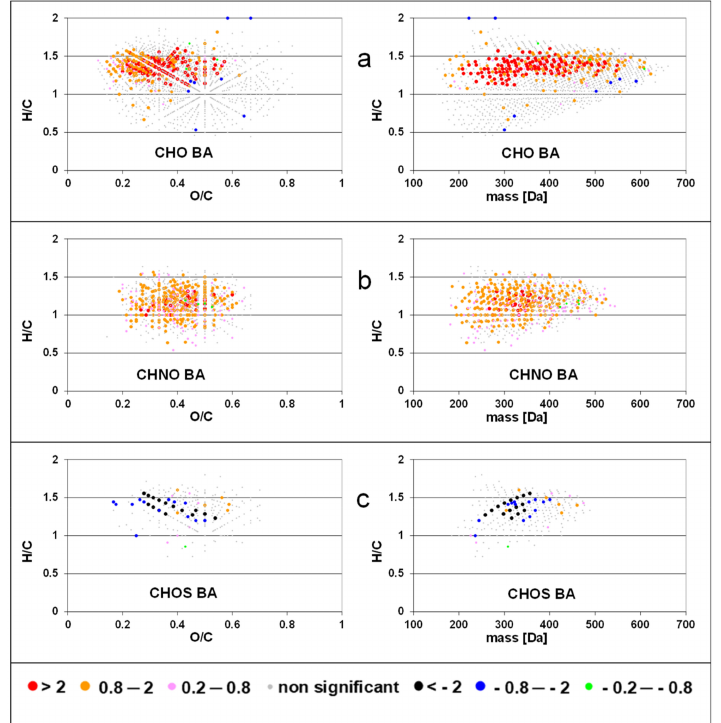
Figure 3. Slopes of regressions between intensities of solid phase extractable dissolved organic matter (SPE-DOM) molecular formulas and standardized bacterial abundance for CHO ( a ); CHNO ( b ); and CHOS components ( c ). See also the data base in the Supplementary